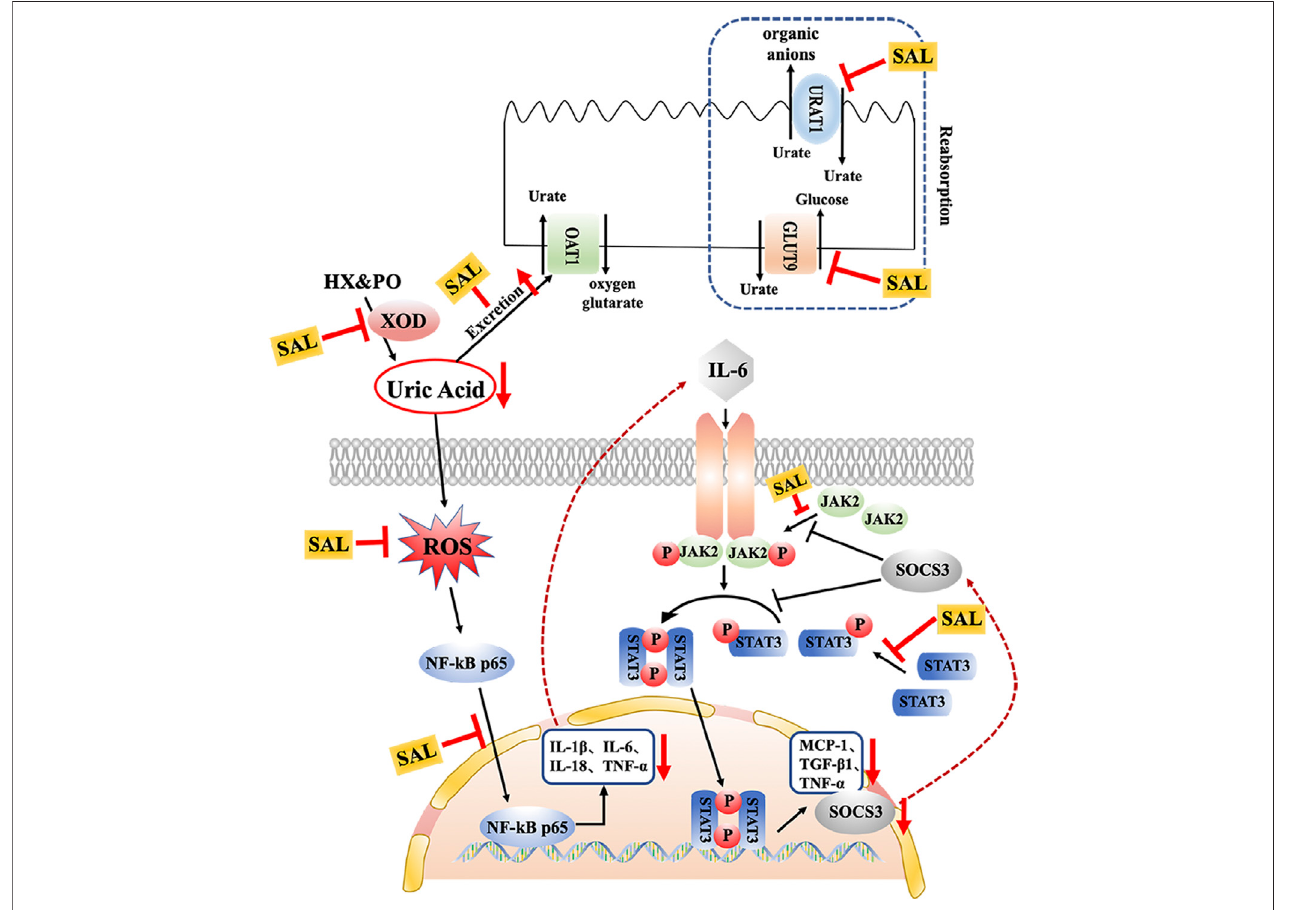
FIGURE 11 | Schematic diagram of the proposed mechanisms of SAL protective effect against PO- and HX-induced HUA in mice.